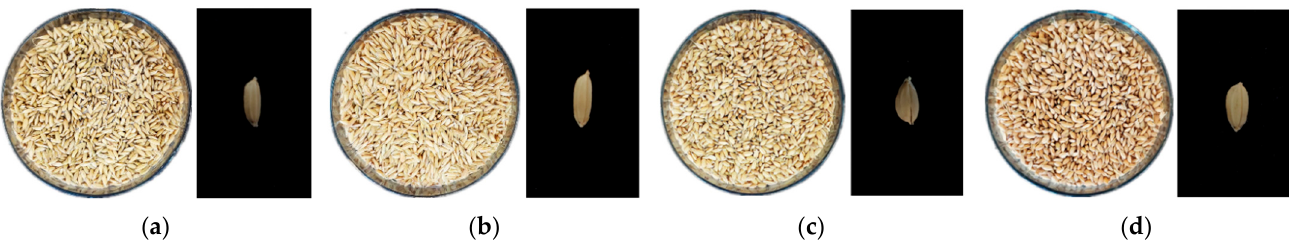
Figure 1. Typical rice varieties in main rice producing areas of Northeast China: ( a ) Longjing 29; ( b ) Wuyoudao 4; ( c ) Jijing 88; ( d ) Shennong 9903.